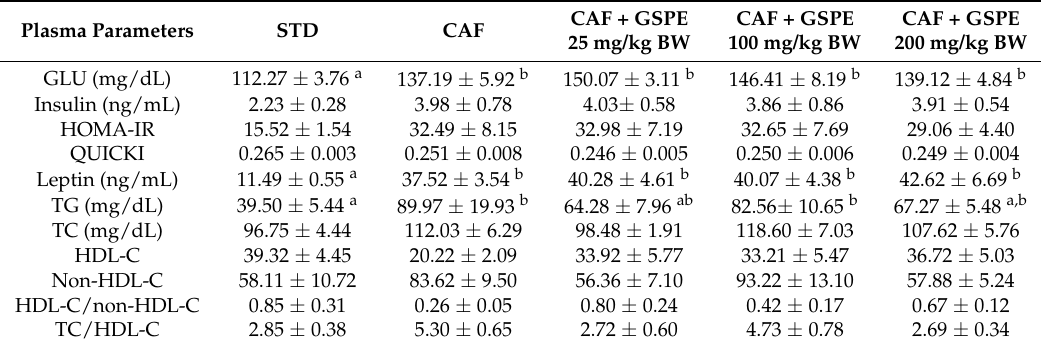
CAF + GSPE CAF + GSPE CAF + GSPE 25 mg/kg BW 100 mg/kg BW 200 mg/kg BW